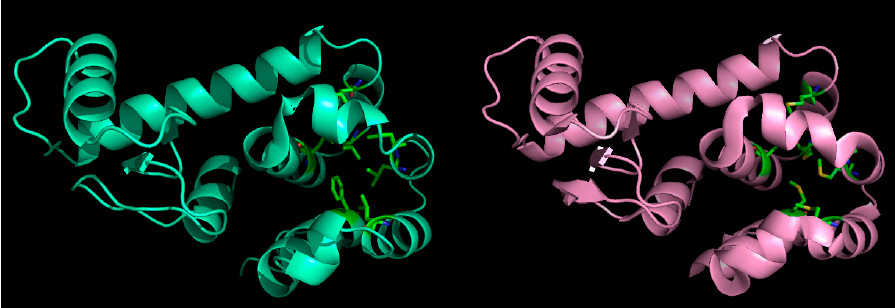
Figure 2. Effect of mutations in globular proteins: seven core (hydrophobic) residues mutated to methionine (left panel: native, right: mutant) in phage T4-lysozyme and yet, the fold is preserved without almost any marked distortions. This happens because of 'structural relaxation' in proteins due to their inherent conformational plasticity (adaptability to changes).